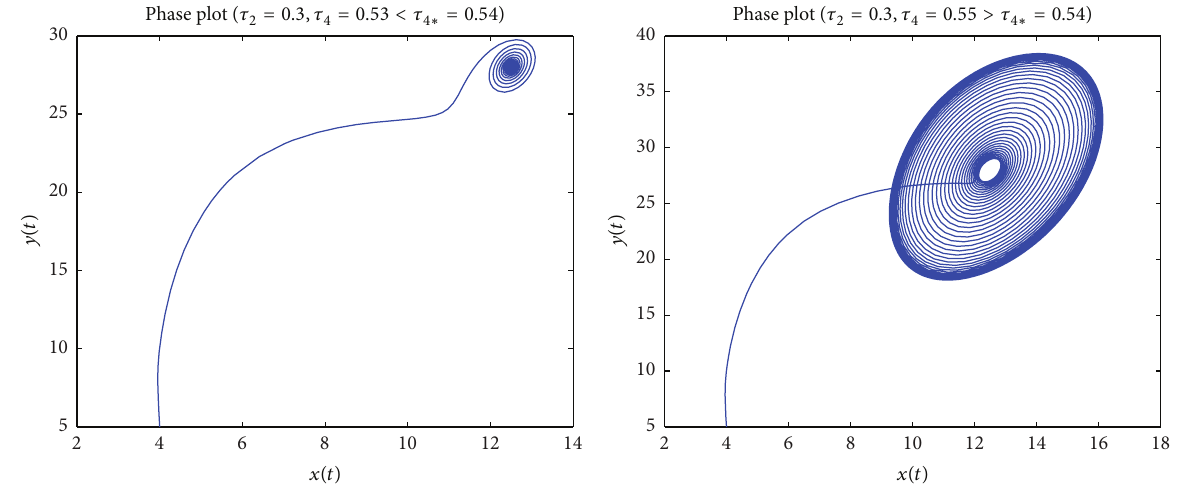
Figure 8: MATLAB simulation shows that system (115) at 𝐸 ∗ undergoes a Hopf bifurcation for 𝜏 4 = 0.55 > 𝜏 4∗ = 0.54 with 𝜏 2 = 0.3 and initial value “4,